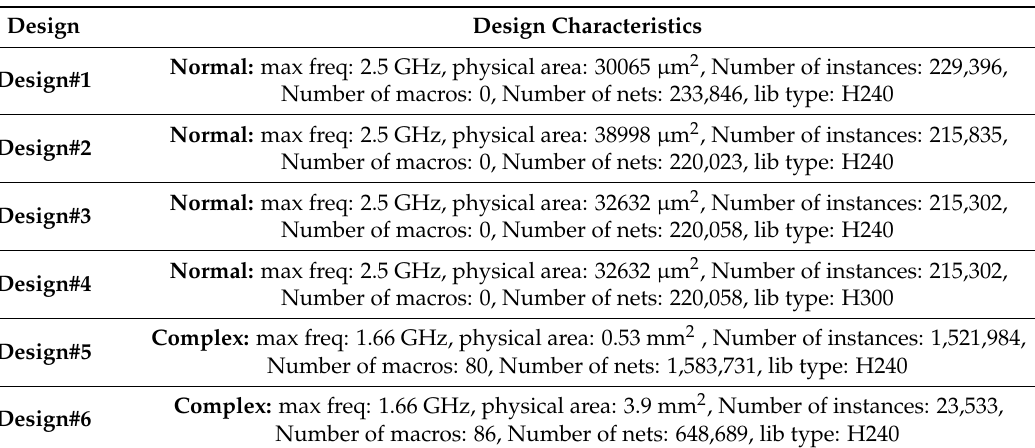
Table 3. Characteristics of used designs.